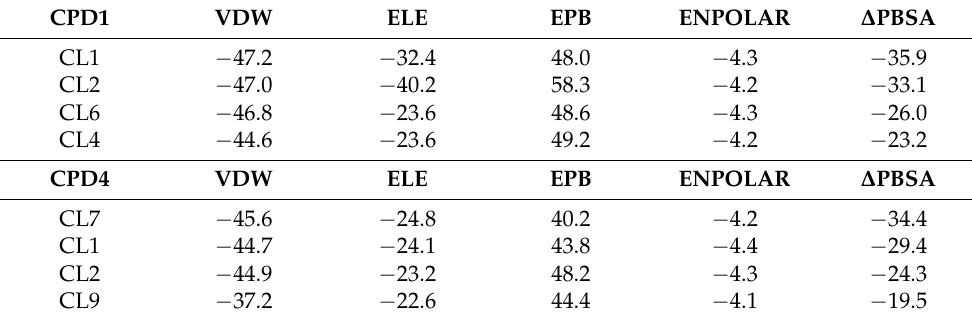
Table 4. MM-PBSA results for the analyzed Cdk5-CPD1/4 complexes. ∆ PBSA is the sum of the van der Waals (VDW), electrostatic (ELE), as well as polar (EPB) and non-polar (ENPOLAR) solvation free energy. Data are expressed as kcal · mol − 1